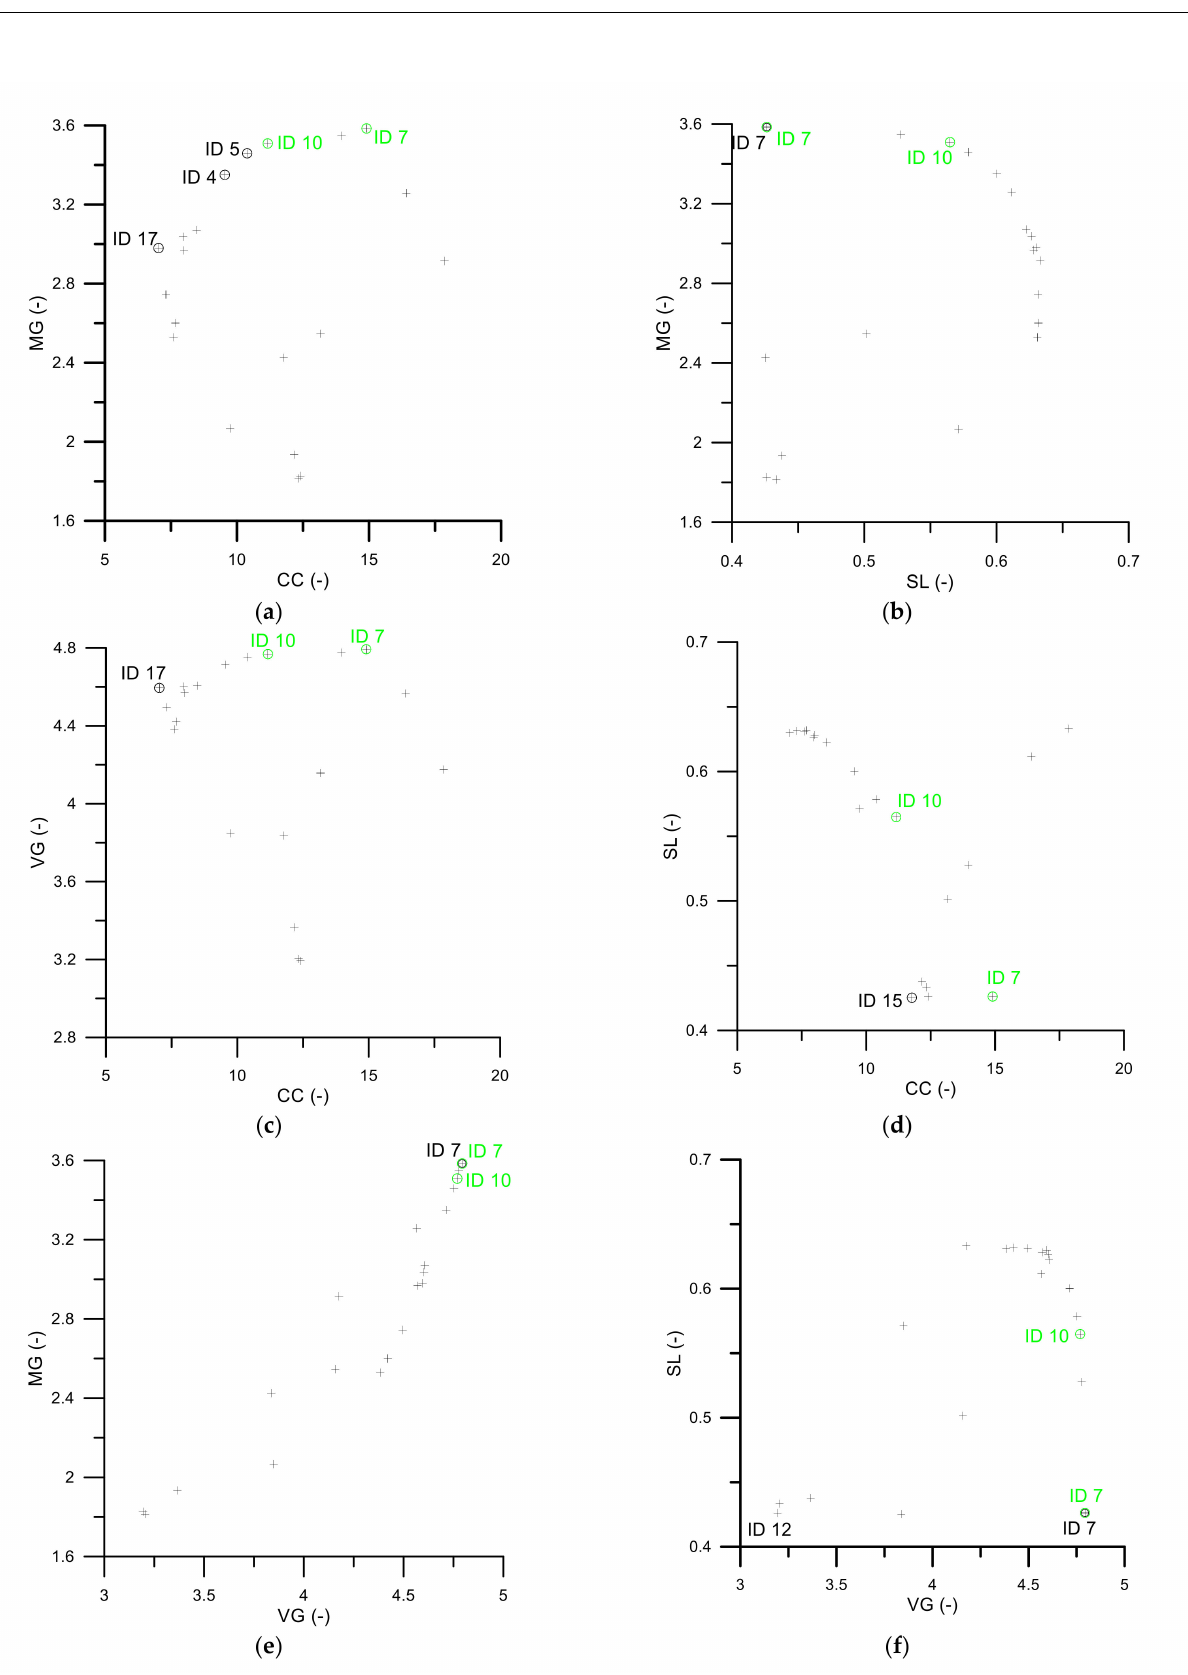
Figure 4. Pareto fronts: ( a ) MG-CC, ( b ) MG-SL, ( c ) VG-CC, ( d ) SL-CC, ( e ) MG-VG, ( f ) SL-VG; +—data, O—the best solutions, O—ID 7 and ID